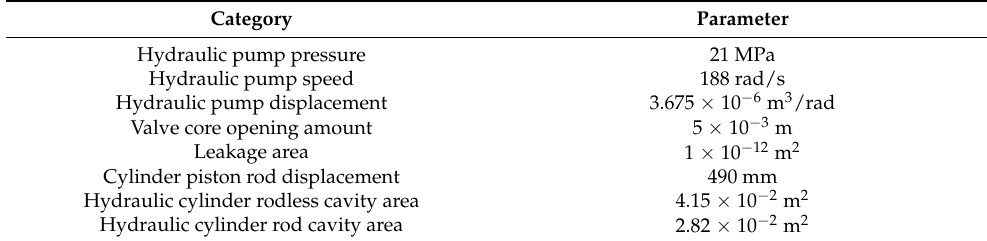
Table 1. The main parameters of the